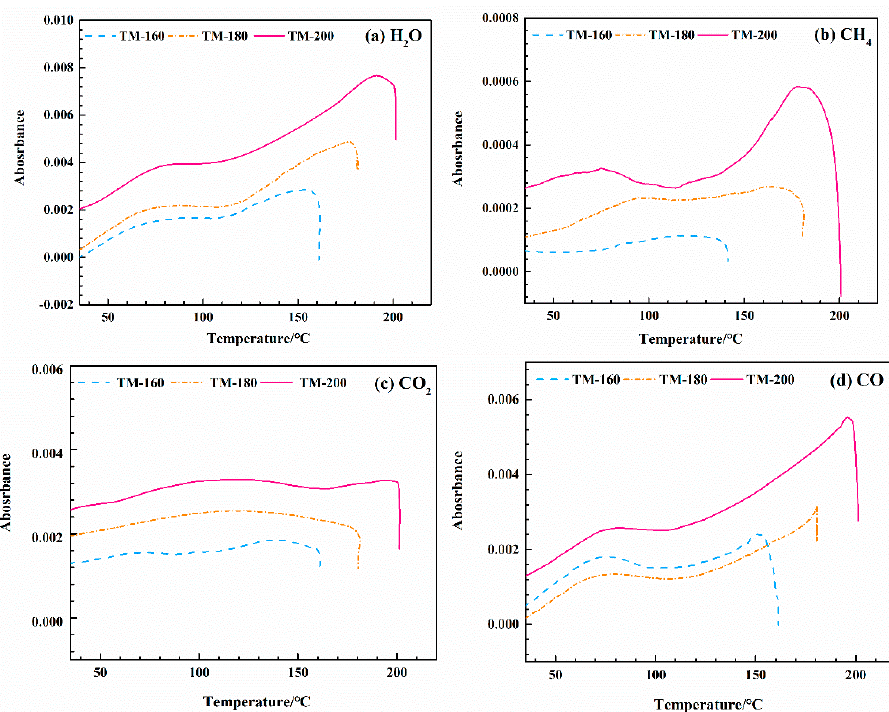
Figure 11. Evolution of evolved gas components during wood thermal modification at different temperatures: ( a ) H 2 O; ( b ) CH 4 ; ( c ) CO 2 ; and ( d ) CO.